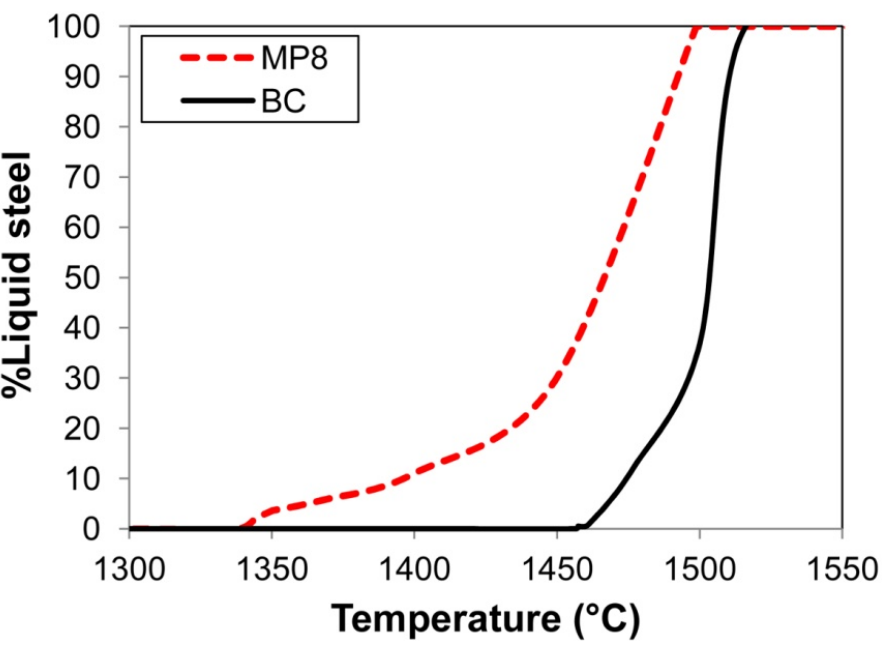
Figure 3. Effect of weld metal compositions on solidification curves: BC vs. MP8 weld metal compositions.